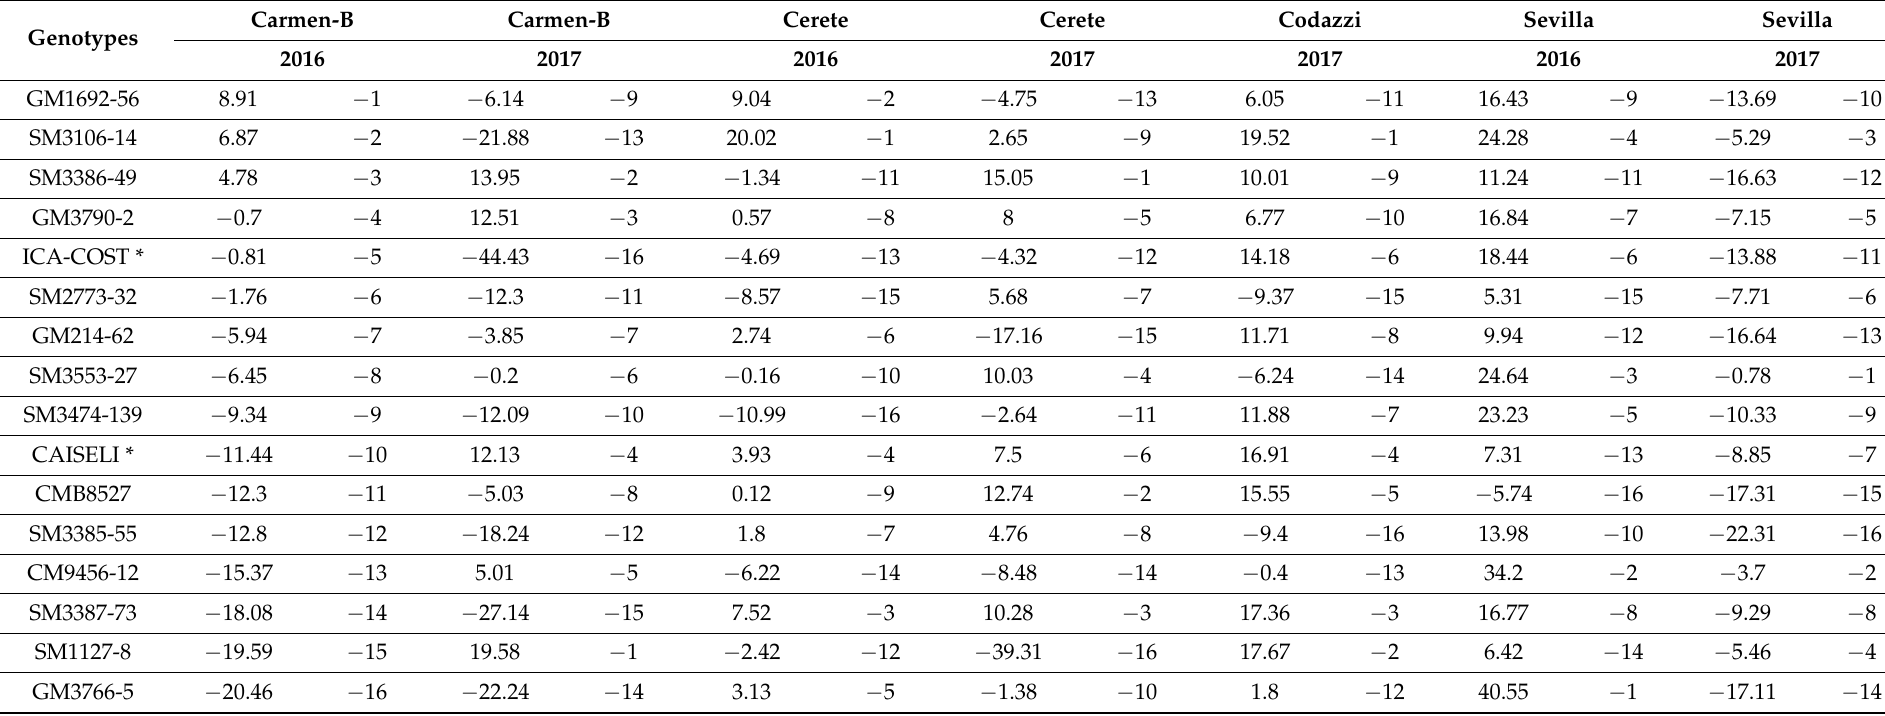
Table 5. Classification of 16 cassava genotypes using the selection index (SIN) evaluated in seven environments of the Colombian Caribbean region.